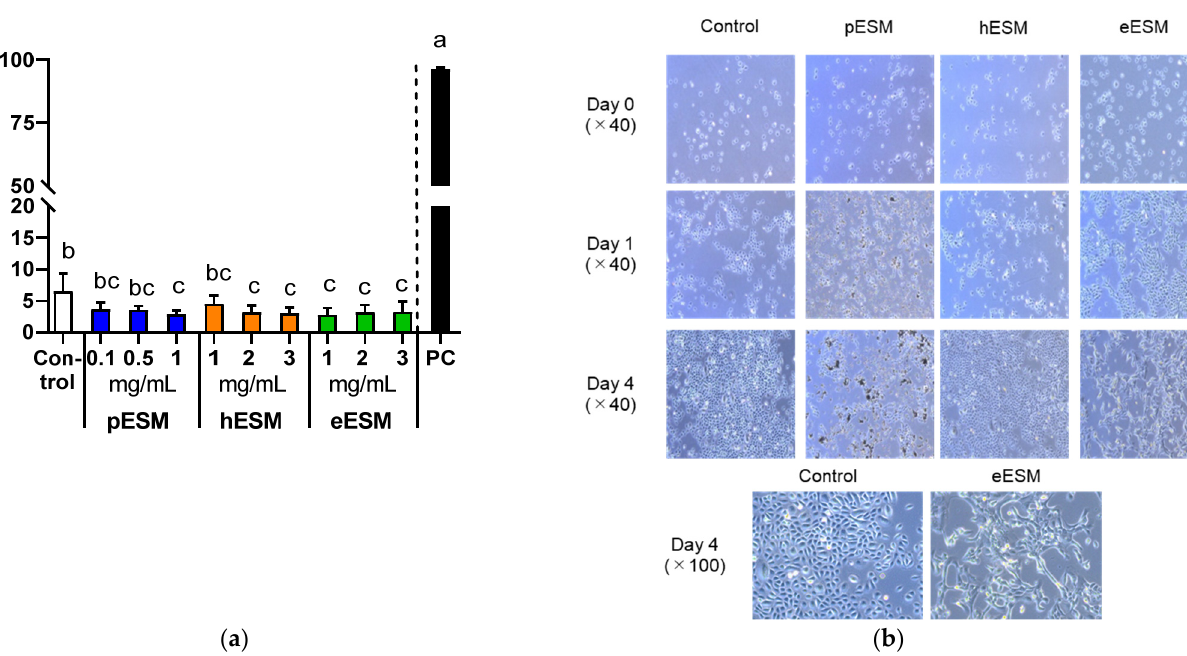
Figure 1. Effects of three types of ESMs on cell cytotoxicity and morphological characterization of NHEK-Neo cells. ( a ) Cell cytotoxicity based on LDH assay in response to different concentrations of pESM, hESM and eESM. 0.2% Tween-20 ( v/v ) was used as the positive control (PC). Data are means ± SD and expressed as % ( n = 4). The calculation is shown in the Materials and Methods; ( b ) Morphological changes of NHEK-Neo cells in response to 0.1 mg/mL of pESM, and 1 mg/mL of hESM and eESM each. The different lowercase alphabets indicate significant differences between the tested-group ( p < 0.05).